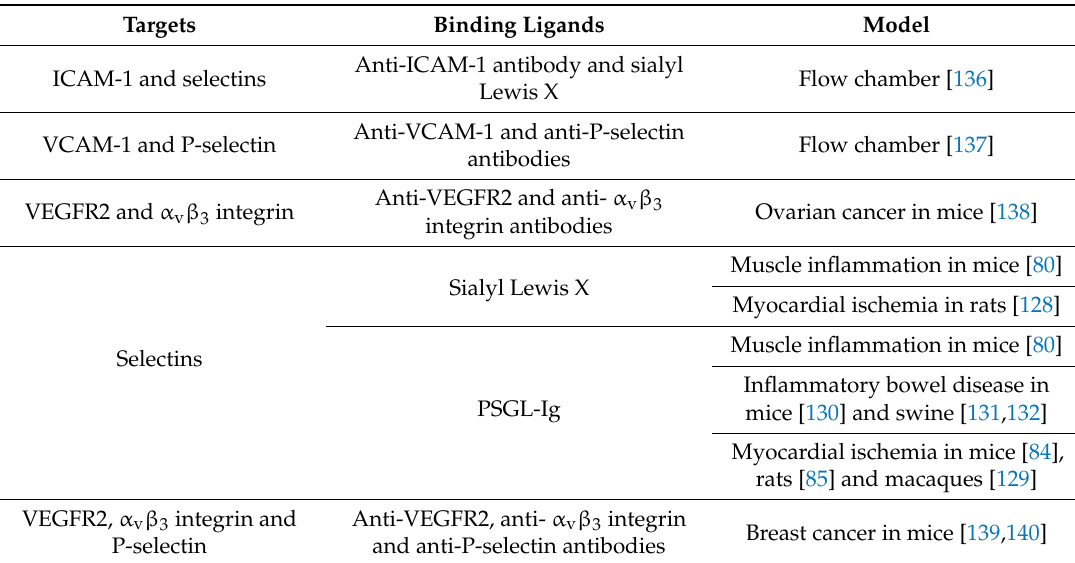
Table 2. Summary of multi-targeted MB investigated for molecular US